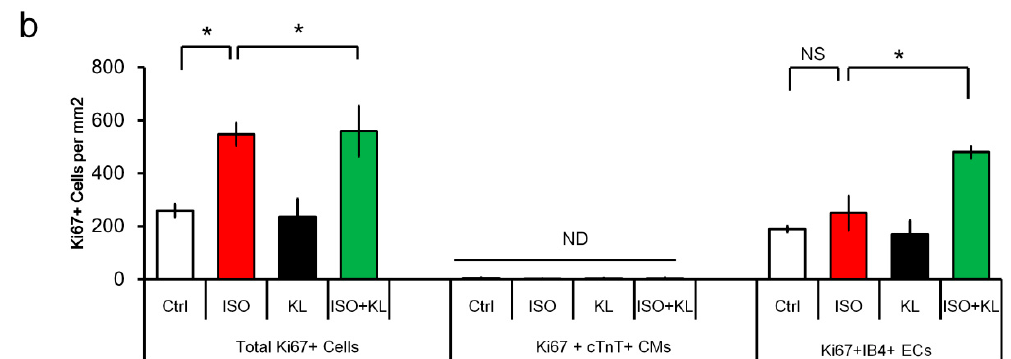
Figure 3. KL inhibited isoproterenol-induced cell death in vivo. ( a ) Quantification of immunofluorescent staining for TUNEL+ cells, TUNEL+cTnT+ cardiomyocytes, and TUNEL+IB4+ endothelial cells in the cardiac tissues. ( b ) Quantification of immunofluorescent staining for Ki67+ cells, Ki67+cTnT+ cardiomyocytes, and Ki67+IB4+ endothelial cells in the cardiac tissues. * denotes p < 0.05. NS, no significance. ND, not detectable.